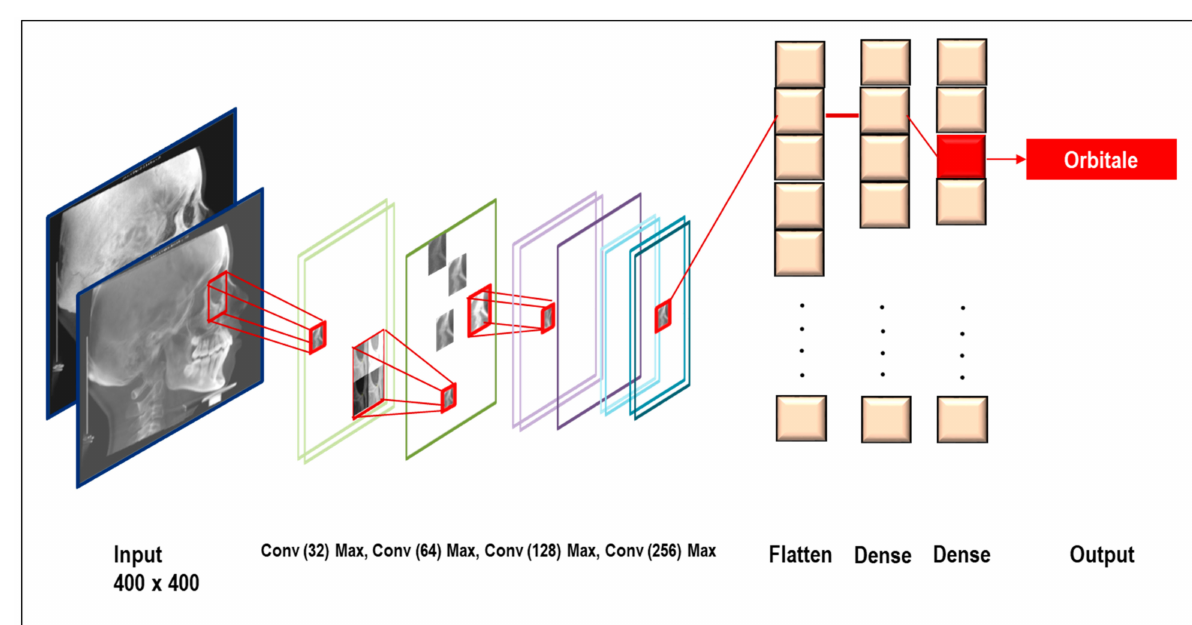
Figure 2. Schematic diagram of our proposed multi-stage CNNs architecture. Put the preprocessed image data. Input data passing through the deep CNNs model of composition with 6 convolution layers, with 32 × 2, 64 × 2, 128, 256 nodes, and max pooling for the features to be extracted. Subsequently, the two dense layers classified the features to make final decision.